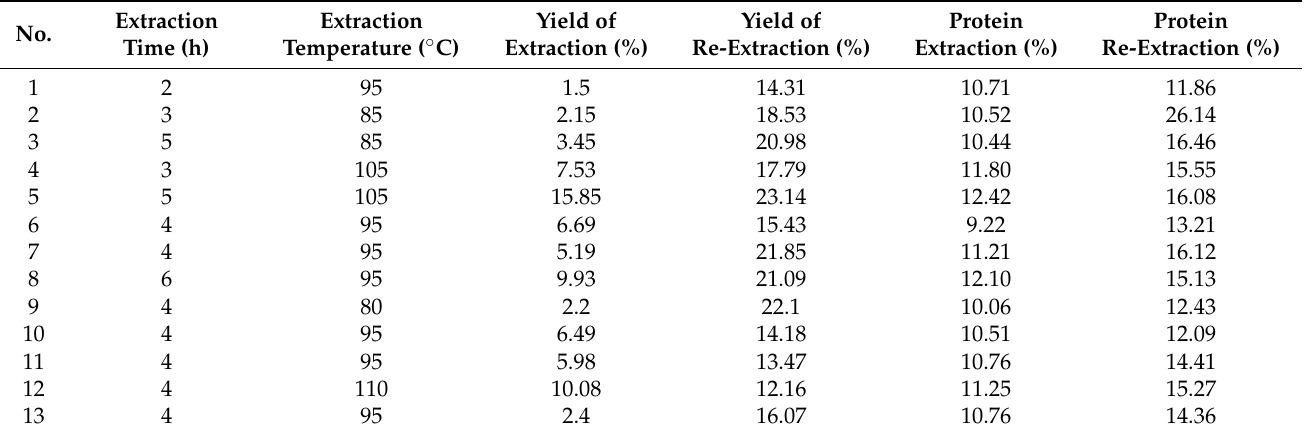
Table 1. Response surface central composite design (coded and uncoded) and the results of the conventional extraction and re-extraction yield of